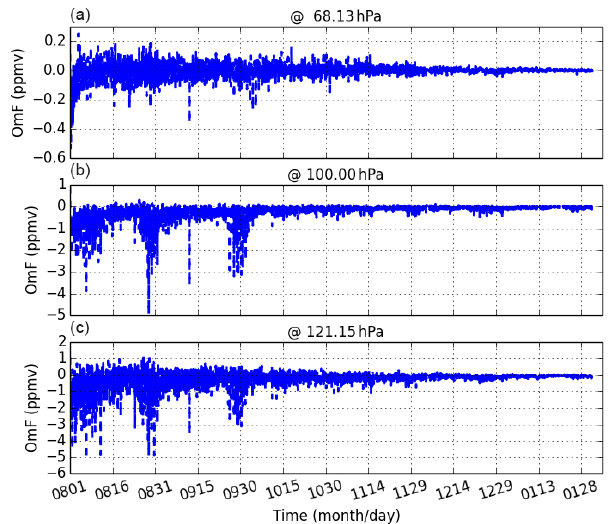
Figure 4. Observations minus forecasts zonally averaged over the tropics (30 ◦ S–30 ◦ N) from 1 August 2011 to 31 January 2012 at 121hPa (c) , 100hPa (b) and 68hPa (a) . Figure 5. Monthly averaged vertical profiles of H 2 O in the trop-